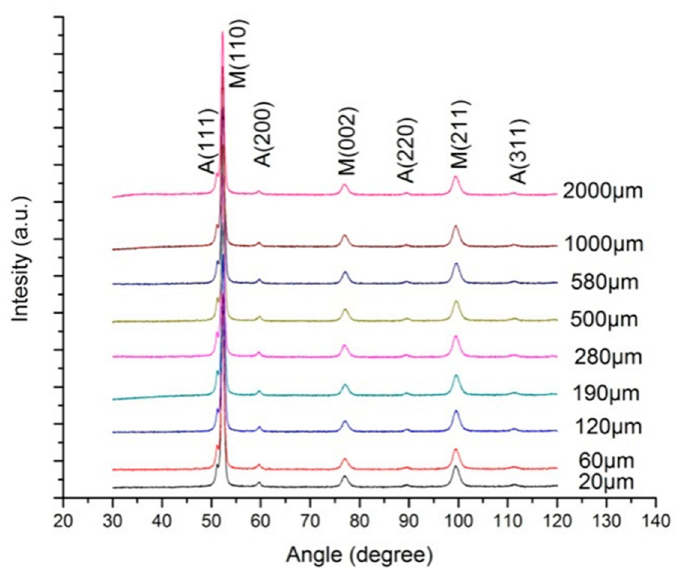
Figure 18. X-ray diffraction pattern from 20°~130°. Table 8. The content of the microstructure from